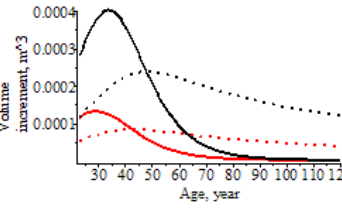
Figure 8. Dynamics of the current and mean annual tree volume increments versus age for two randomly selected stands from the validation dataset and mixed-effect scenario. Black color—the first stand; red color—the second stand. Table 13. Statistical indexes for the mean tree volume, , (m 3 ) model, using the mixed-effect scenario.